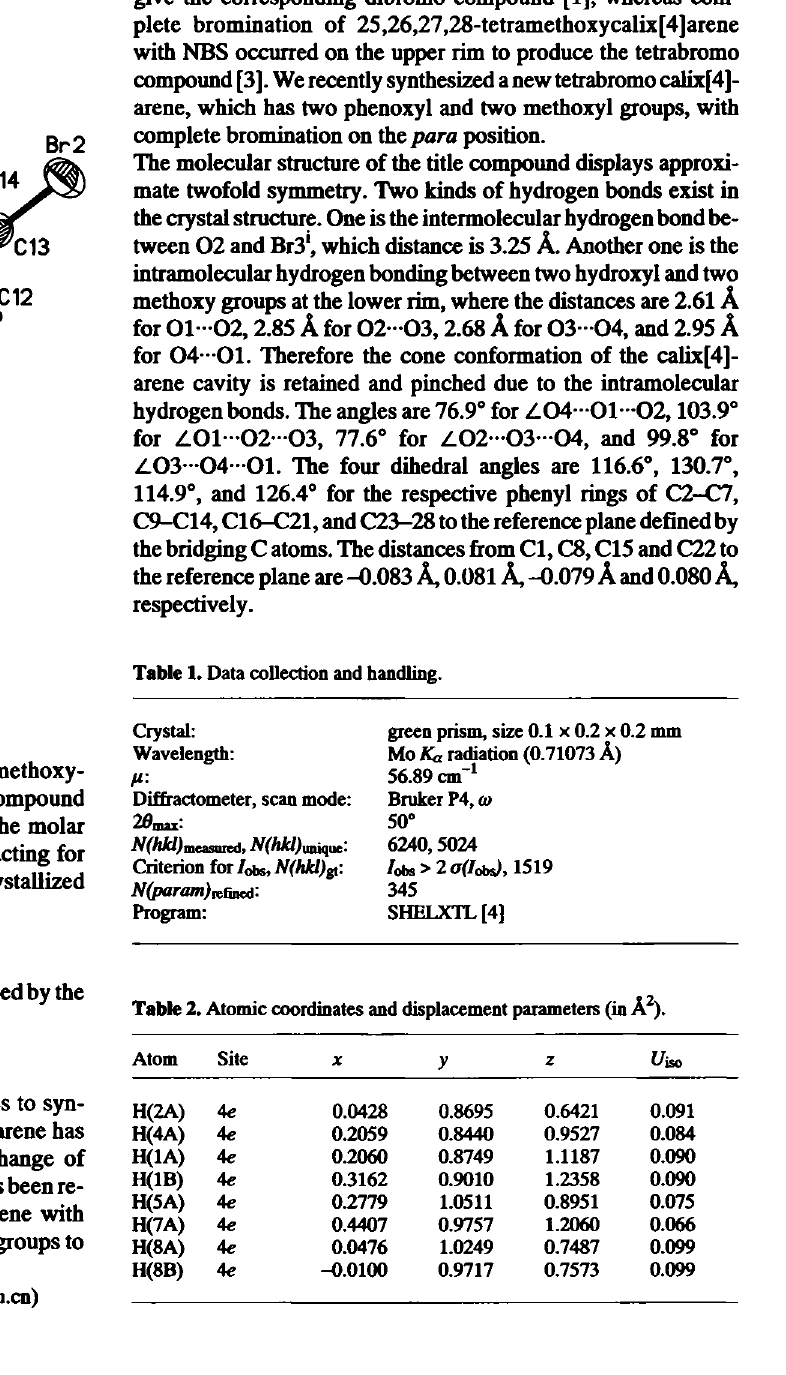
Table 2. Atomic coordinates and displacement parameters (in A 2